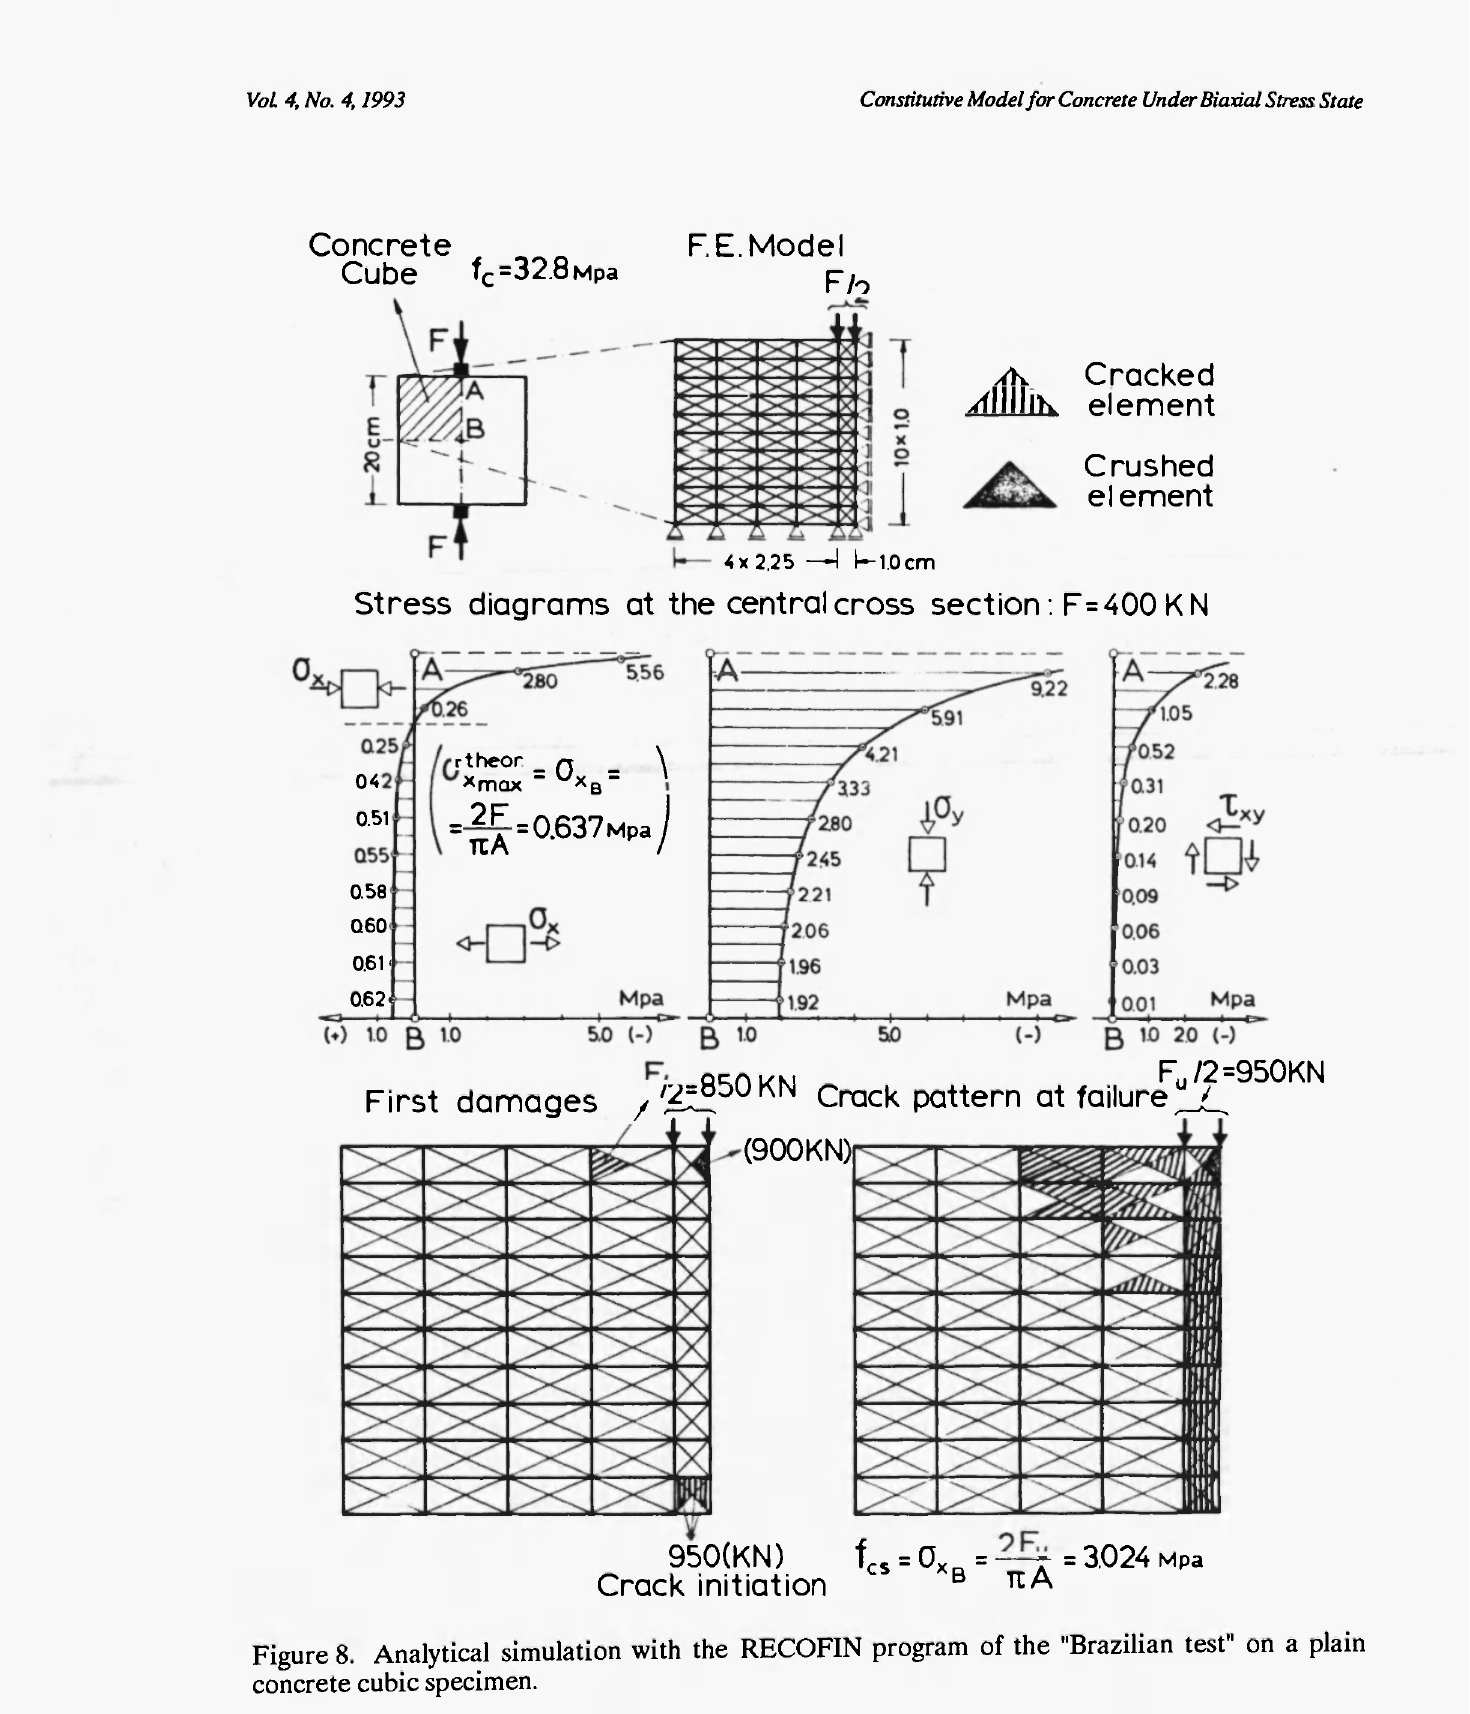
Figure 8. Analytical simulation with the RECOFIN program of the "Brazilian test" on a plain concrete cubic